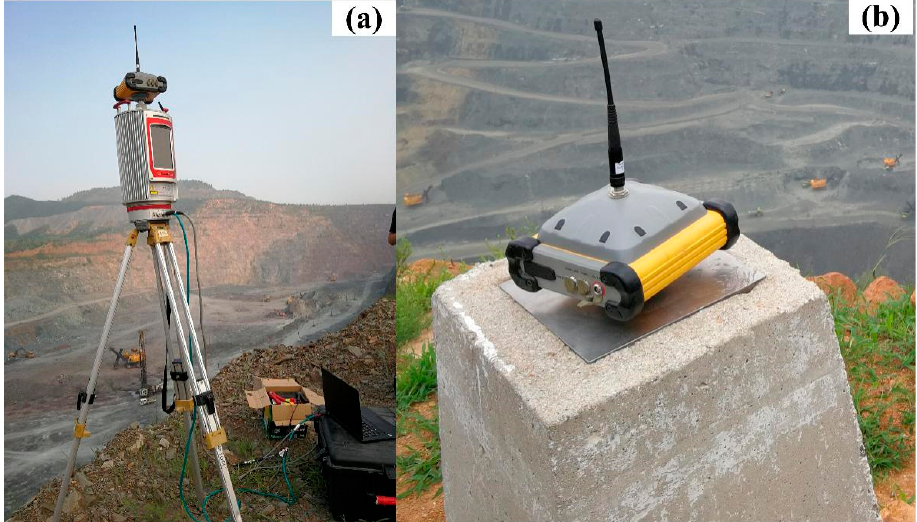
Figure 2. The instruments used in the experiments. ( a ) A long-range terrestrial laser scanner, i.e., Riegl VZ-4000. ( b ) A GNSS rover, i.e., SOUTH S86, fixed on the permanent control point, for correcting the system error. Table 1. Technical specifications of the terrestrial laser scanning (TLS) instrument used in the experiment.